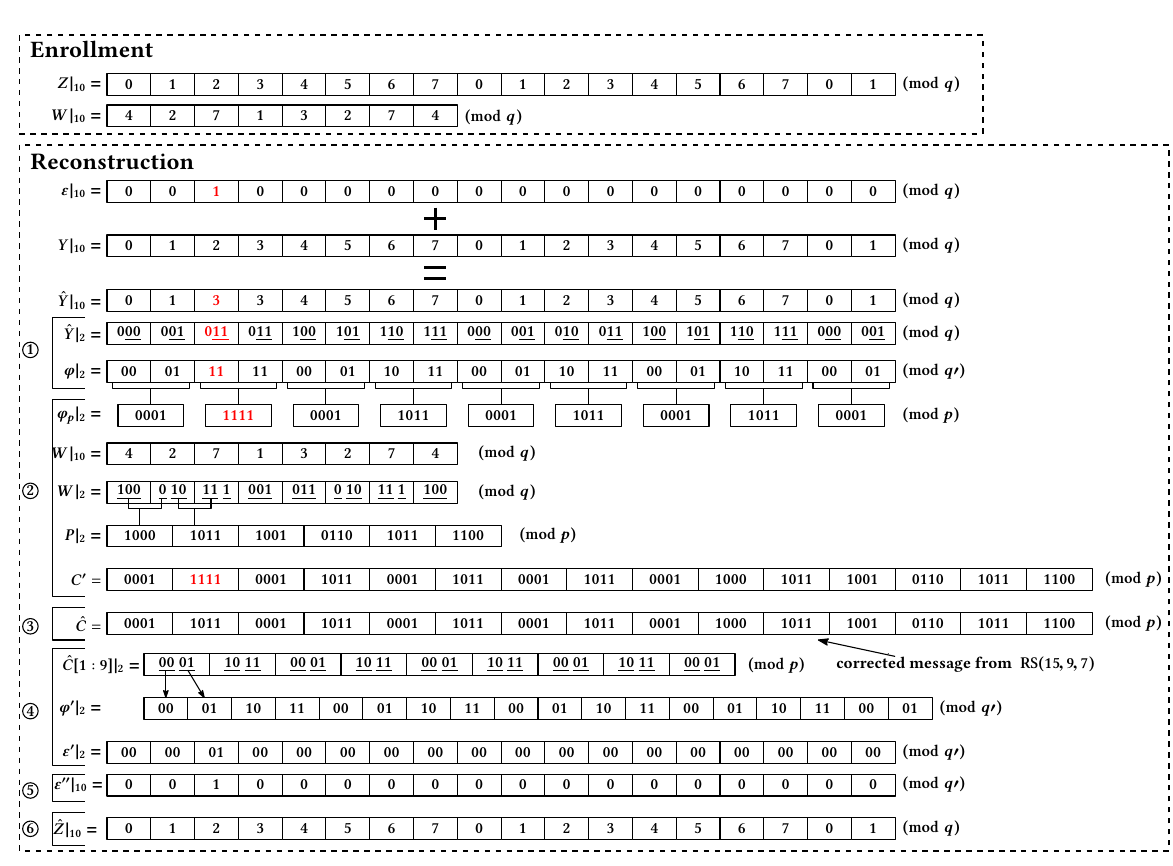
Figure 12: LMC example for successful decoding (q=8, q 0 = 4 , l u = 2 , l d = − 1,